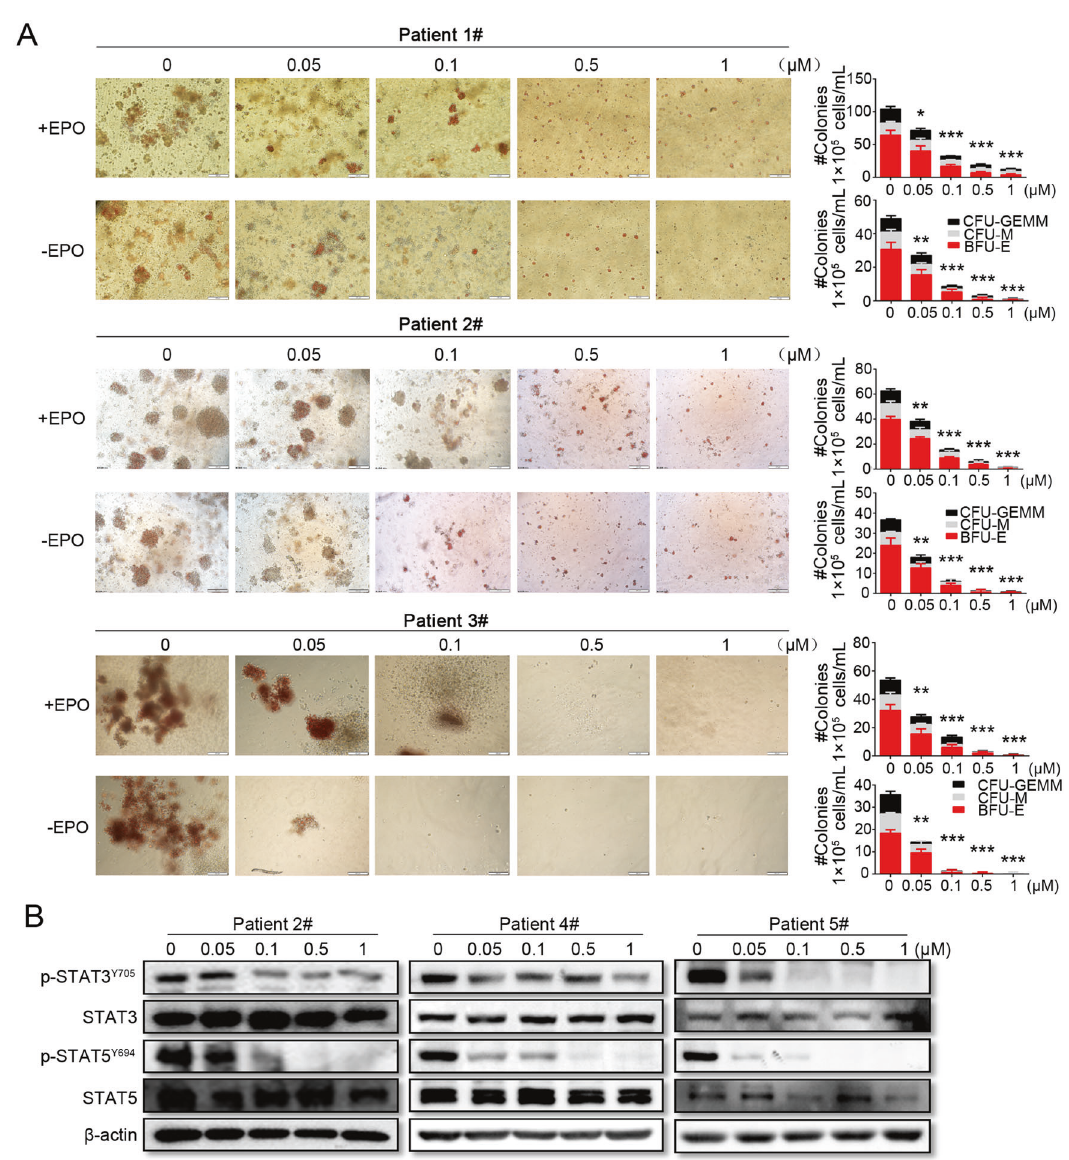
Fig. 7 Effects of FM on erythroid colony formation and JAK2/STAT signaling in MPN patient samples with activating JAK2 V617F mutation. A Mononuclear cells were isolated from the PB or BM of patients with MPNs (Patient Number: 1#, 2#, and 3#) and incubated with FM in methylcellulose-based media. Hematopoietic colony-forming capacity was calculated by the total number of BFU-E, CFU-M, and CFU-GEMM on day 14. B MPN patient cells (Patient Number: 2#, 4#, and 5#) were incubated with various concentrations of FM for 4 h, and the phosphorylation of STAT3 and STAT5 were analyzed via western blot analysis. Data are represented as mean ± SD, * p < 0.05, ** p < 0.01, *** p < 0.001 vs. vehicle, t